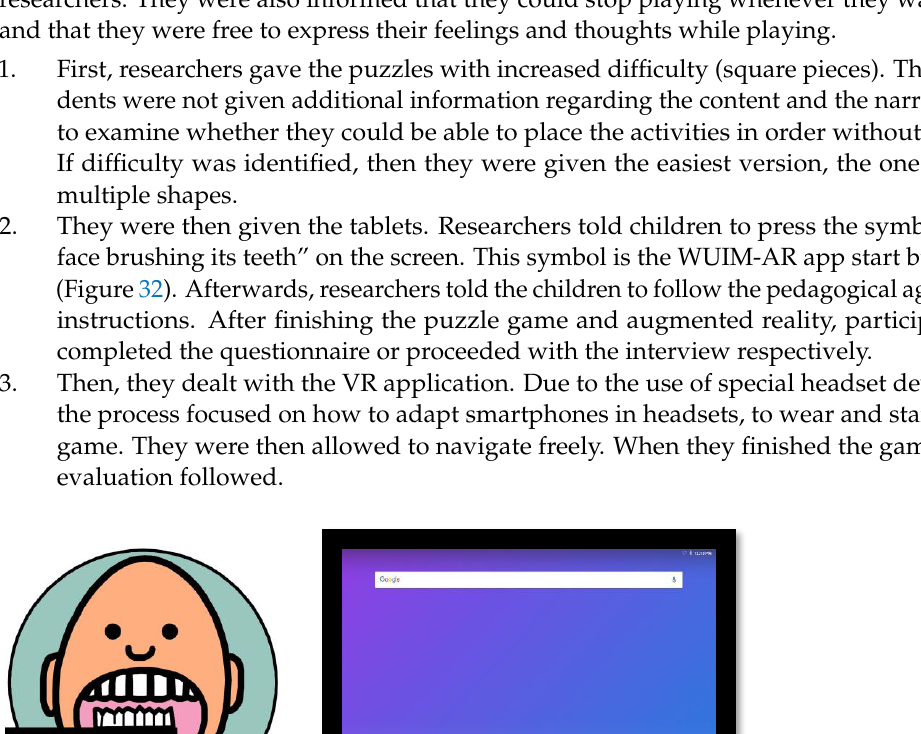
Figure 32. ( a ) WUIM-AR start button; ( b ) WUIM-AR button/icon on screen.